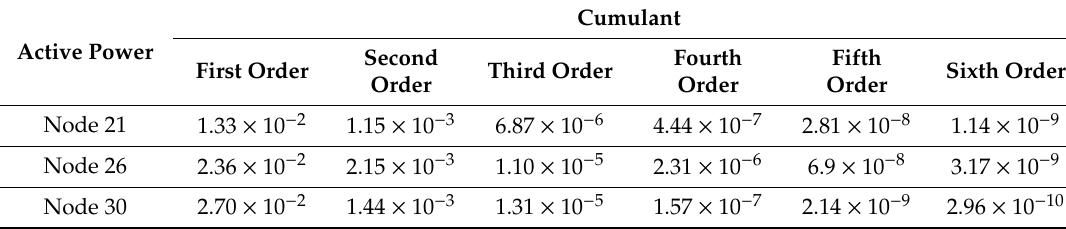
Figure 4. Probability distribution of node voltage; ( a ) EV ( b ) Distributed wind power ( c ) Distributed solar PV.